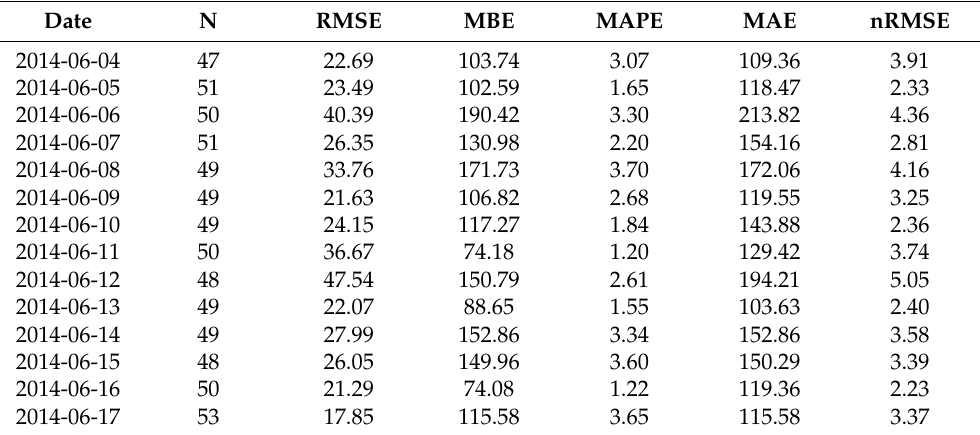
Table 3. Statistical metrics of the inverter 4 of PVS1 for the period 5 June 2014 to 17 June 2014 (normal